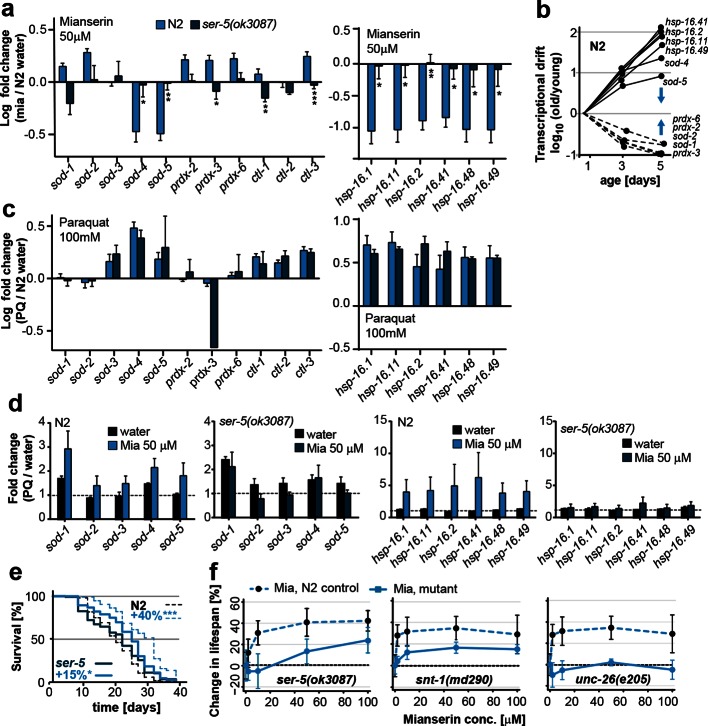
Mianserin attenuates drift-variance in peripheral tissues via SER-5.(a) Bar graphs quantifying transcriptional drift (log fold-changes in gene expression) as measured by qRT-PCR in 5-day-old N2 and ser-5(ok3087) animals treated with mianserin, relative to water-treated N2. Mianserin treatment increases expression of genes drifting down with age and decreases expression of genes drifting up with age in N2, but not in ser-5(ok3087) mutants. (See 5b). *P<0.05, **P<0.01, ***P<0.001,t-test; Error bars: S.E.M. (b) Log fold-change in gene expression as a function of age for stress response genes shown in a. Blue arrows indicate how mianserin treatment corrects age-associated changes in gene expression toward an expression pattern as seen in young adults. (c) Bar graphs quantifying log fold-changes in gene expression in 1-day-old N2 and ser-5(ok3087) animals treated with paraquat, relative to water-treated N2 animals. N2 and ser-5(ok3087) show an identical response to paraquat. (d) Mianserin treatment on day 1 of adulthood enhances transcription of sod and hsp-16.x genes in response to an 8h paraquat treatment on day 5 in wt (N2) animals compared to water treated controls. In contrast, mianserin treatment of ser-5(ok3087) animals did not enhance transcription of sod and hsp-16.x genes. mRNA levels of genes were evaluated by qRT-PCR and plotted as fold induction (PQ/water) (Y-axis) for each gene. (e) Survival plot of mianserin-treated and untreated N2 and ser-5(ok3087) animals. ***P<0.001, *P<0.05, Mantel–Haenszel version of the log-rank test. f) Percent increase in lifespan as a function of mianserin concentration. Mutations in ser-5 or synaptic components rendered the animals partially or completely resistant to mianserin-induced lifespan extension. See Figure 5—figure supplement 1 for additional data, and Table 8 for detailed statistics.